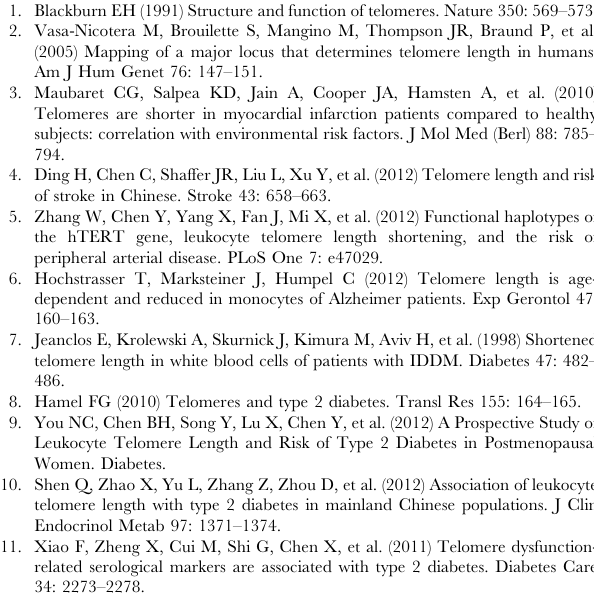
(DOC) Checklist S1 PRISMA checklist. (DOC)